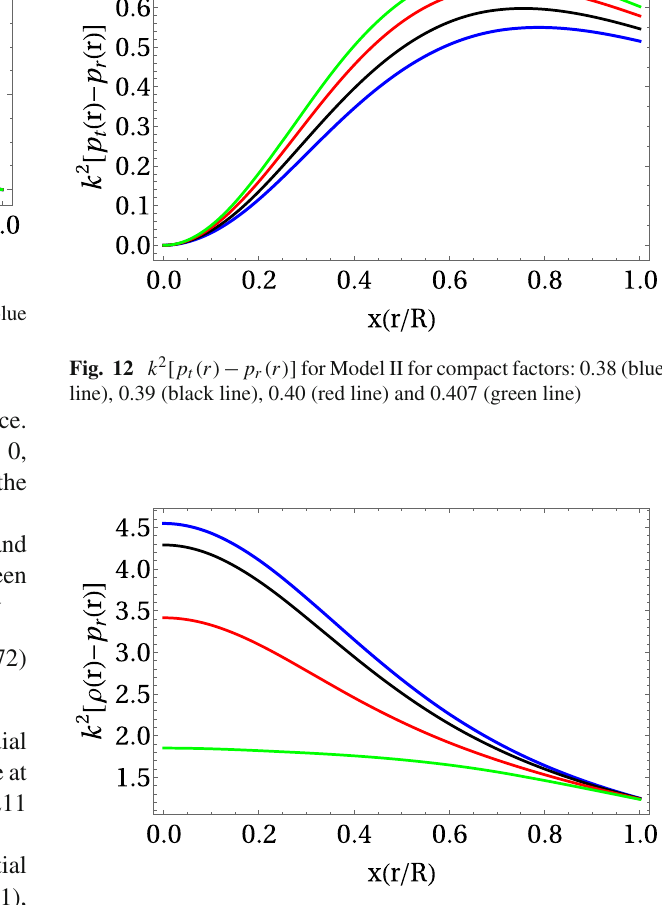
Fig. 13 k 2 [ ρ( r ) − p r ( r ) ] for Model II for compact factors: 0.38 (blue line), 0.39 (black line), 0.40 (red line) and 0.407 (green